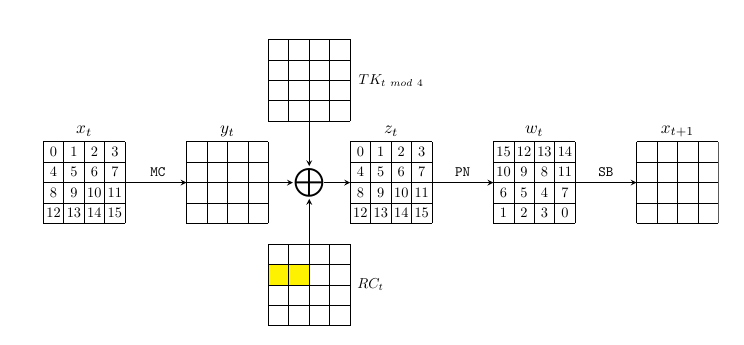
Figure 1: The t -th round of CRAFT